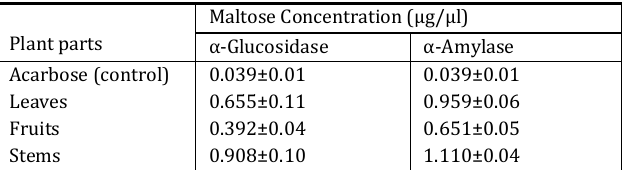
Table 1: M altose concentration (mean ± SEM) generated from α - gl ucosidase and α -amylase enzyme inhibition assay using acarbose and different plant parts of P. niruri as an inhibitor